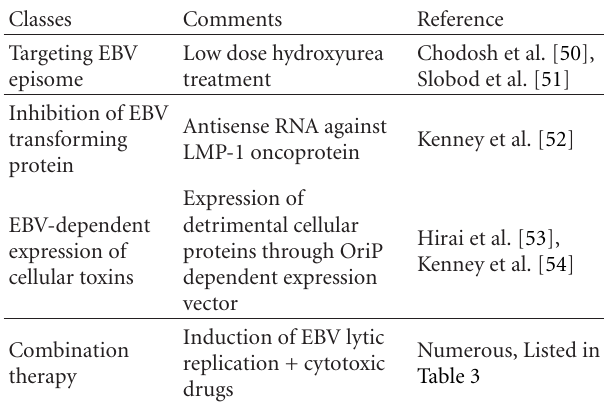
Table 2: Virus-directed novel